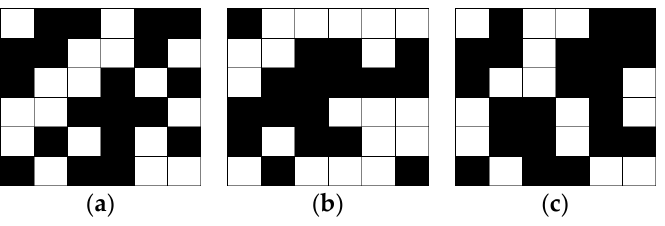
Figure 2. An example of error-correcting coding of copyright watermark data: ( a ) is the original copyright watermark data, ( b , c ) are the first stage and the second stage of ECCs of ( a ), respectively.